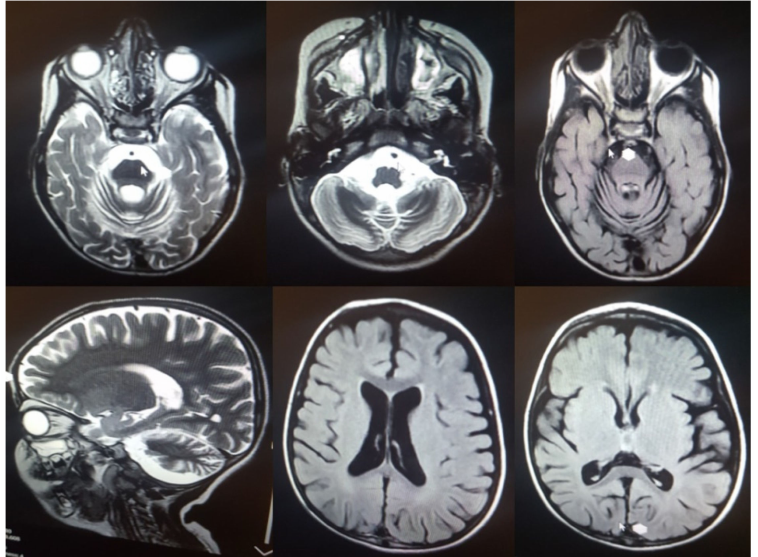
Figure 4. MRI findings in the index case: Hypoplasia of the cerebellar vermis and cerebellar